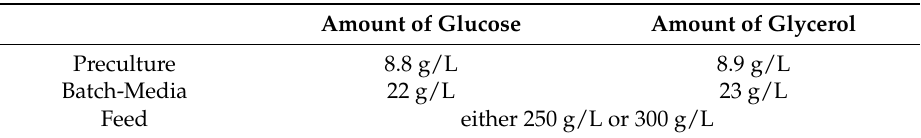
Table 1. Respective sugar concentrations in media